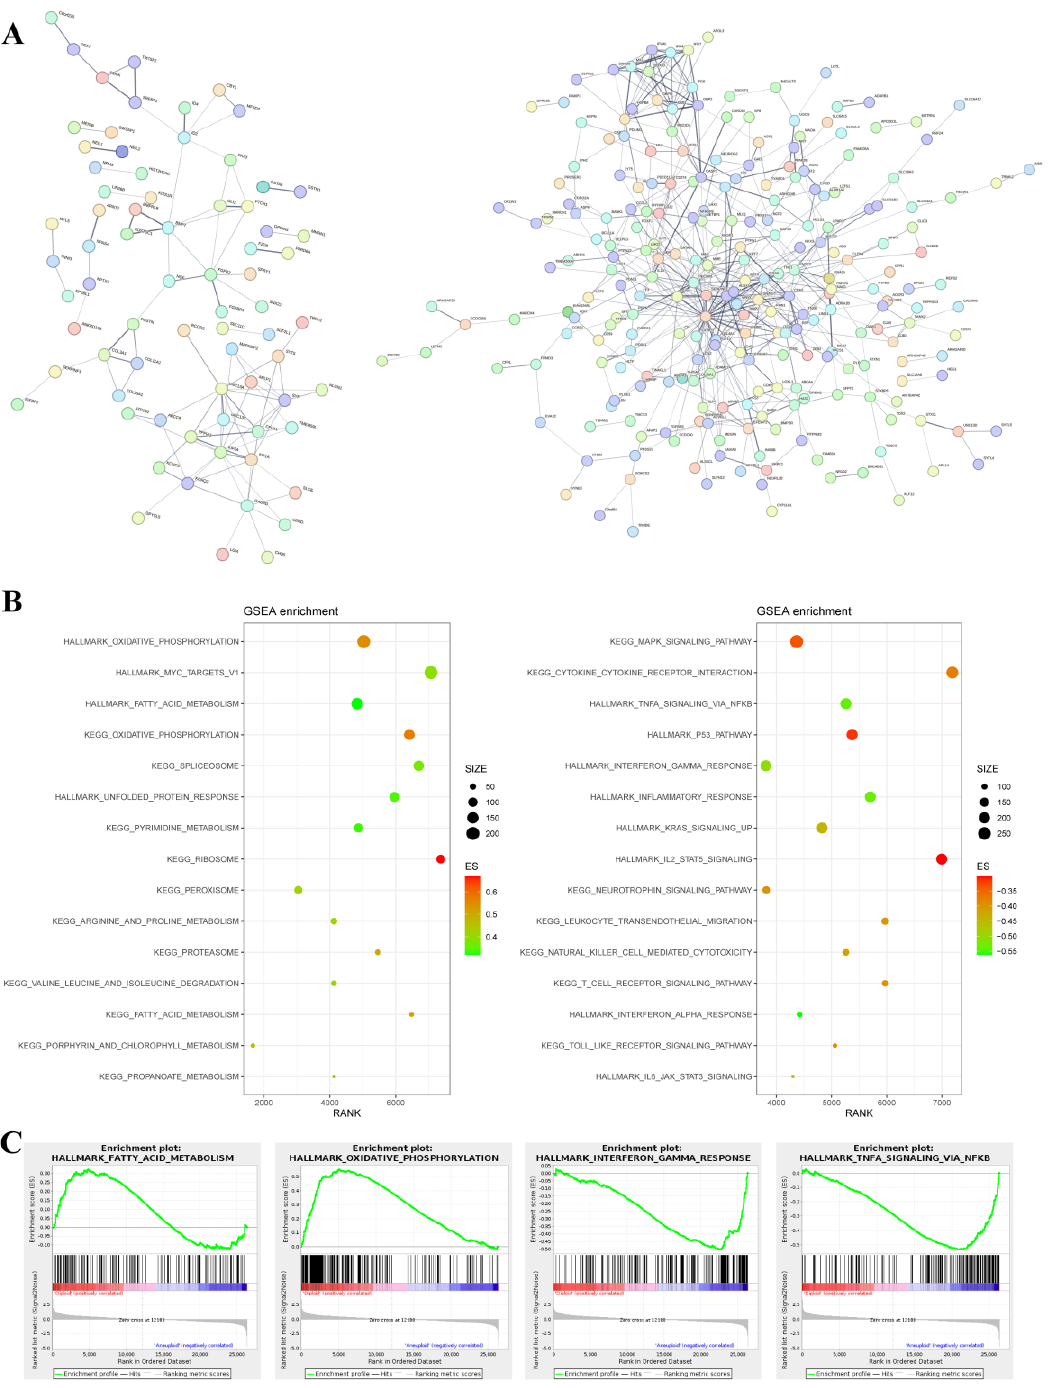
Figure 4. GSEA of the differentially expressed genes. ( A ): Protein-protein interaction enrichment analysis of genes downregulated ( left ) and upregulated ( right ) in aneuploid cell lines. ( B ): GSEA summary of genes downregulated ( left ) and upregulated ( right ) in aneuploid cell lines. ( C ): Significant gene sets (left two panels: downregulated genes in aneuploid group; right two panels: upregulated genes in aneuploid group).